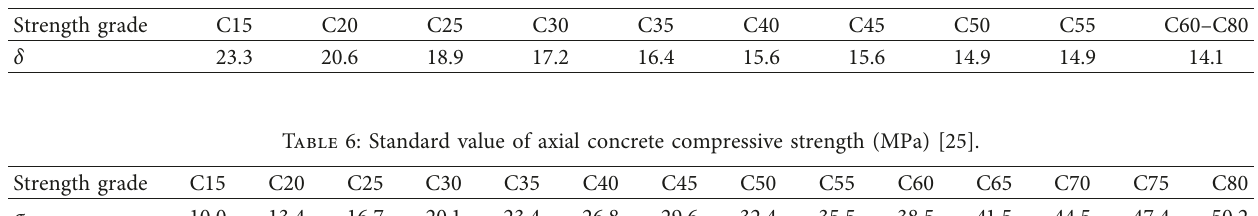
Table 5: Coefficient of variation of concrete strength (%) [25].